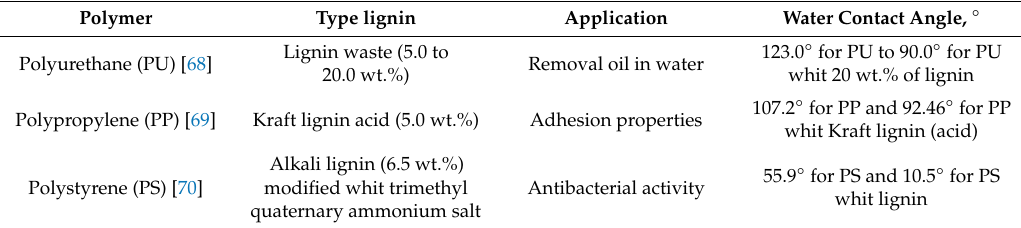
Table 3. E ff ect of lignin in water contact angle for di ff erent polymer